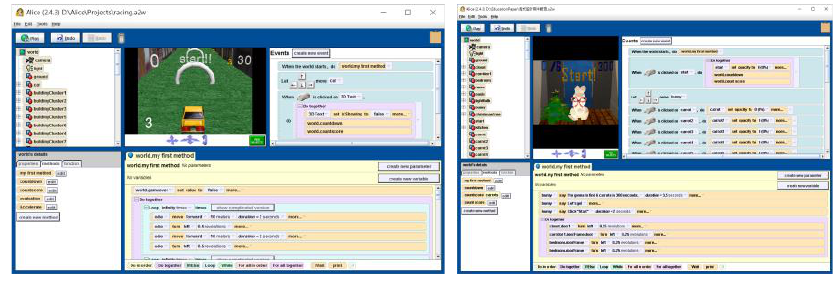
Fig. 1. Games designed and implemented by